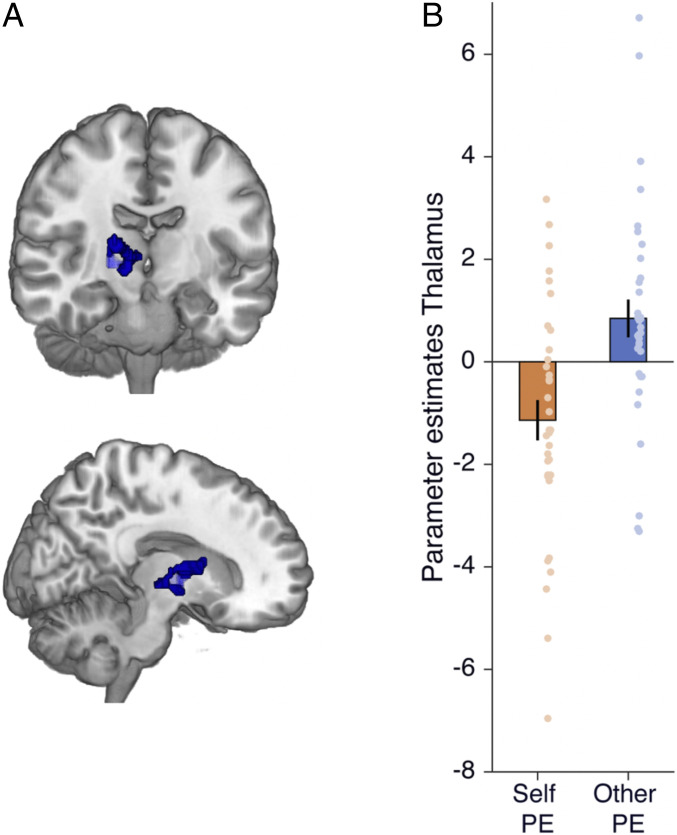
Thalamus/caudate signal distinguishes model-free prediction errors for avoiding harm to other vs. self. (A) Thalamus cluster from the contrast other prediction error > self prediction error (x = 16, y = −18, z = 0, k = 84, P = 0.033, Z = 3.50 FWE-SVC from an independent anatomical mask of the thalamus and x = 12 y = −2 z = 4, Z = 4.08, k = 125, P = 0.005 FWE-SVC after initial thresholding at P < 0.001 for a functional ROI derived from Neurosynth to the term “pain” and x = 10 y = −4 z = 4, Z = 3.83, k = 54, and P = 0.002 FWE-SVC for an 8-mm sphere from a meta-analysis of observed pain (68) overlaid on an anatomical scan to show the extent of activation. (B) For illustration, parameter estimates extracted from the thalamus cluster are shown separately for self and other prediction error (PE). See SI Appendix, Fig. S1 for a meta-analysis of neuroimaging studies with the term “pain” that highlights overlapping activation in the thalamus.